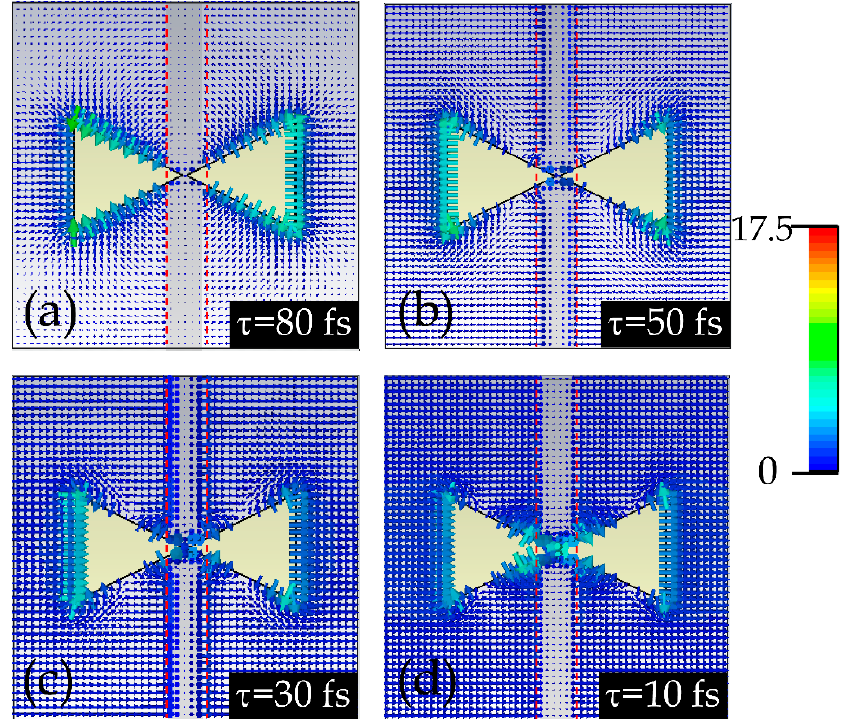
Figure 6. ( a – d ) Simulated electric field distributions of the DTDGS structures with g = 1 um under x -polarized incidences at different graphene scattering time τ from 80 to 10 fs, respectively. The red dotted lines represent the boundaries of the graphene stripes.